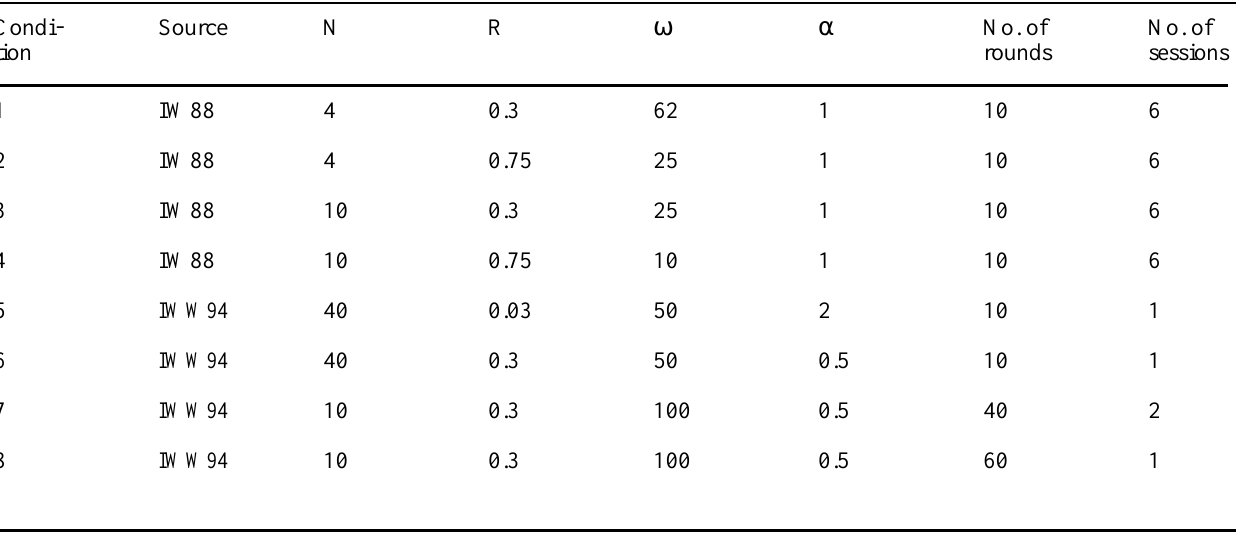
Table 1 . Experimental conditions and parameters. The parameters are defined in Table 2. IW88 signifies that the data are from Isaac and Walker (1988); IWW94 signifies that the data are from Isaac et al. (1994). In all of these eight experimental conditions, the participating players were experienced in the sense that they had previously participated in another public-good game. Also, cash payments were made in all of the eight conditions. The eight conditions are divided into two subsets: six experimental conditions with 10 rounds and two experimental conditions with 40 and 60